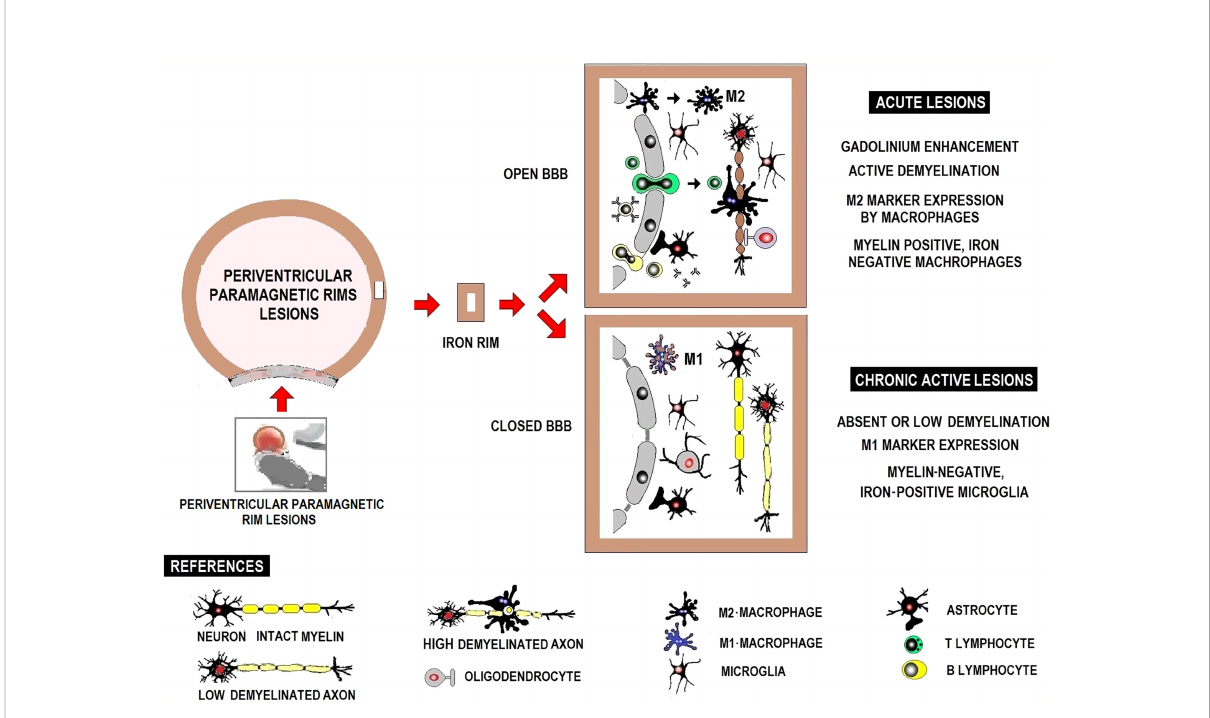
FIGURE 5 Schematic representation of white matter active acute and chronic lesions and in fl ammatory in fi ltrate in periventricular lesions with paramagnetic